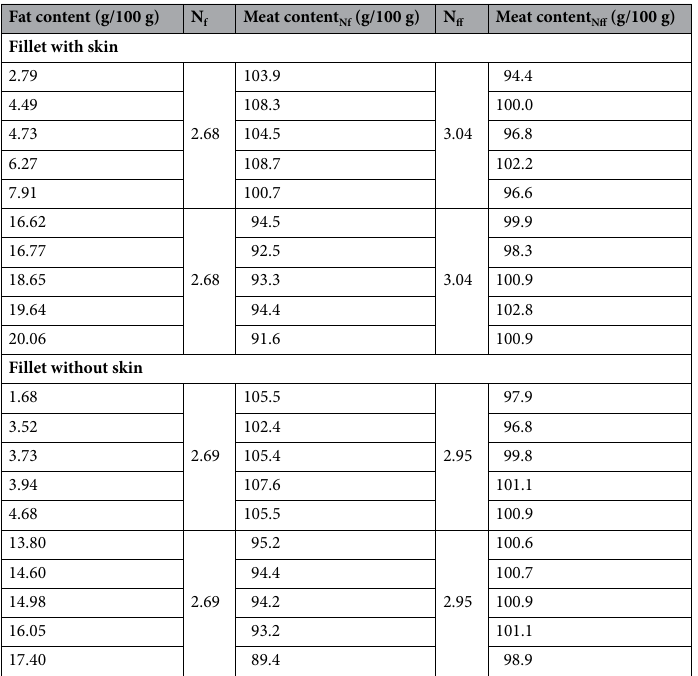
Table 2. Meat content calculated based on recommended nitrogen factors for common carp Cyprinus carpio . Meat content Nf = N × 100/N f (calculated based on nitrogen factor N f (total fillet). Meat content Nff = DCC (defatted meat content) + fat [N × 100/N ff + F] (calculated based on the nitrogen factor N ff (fat-free